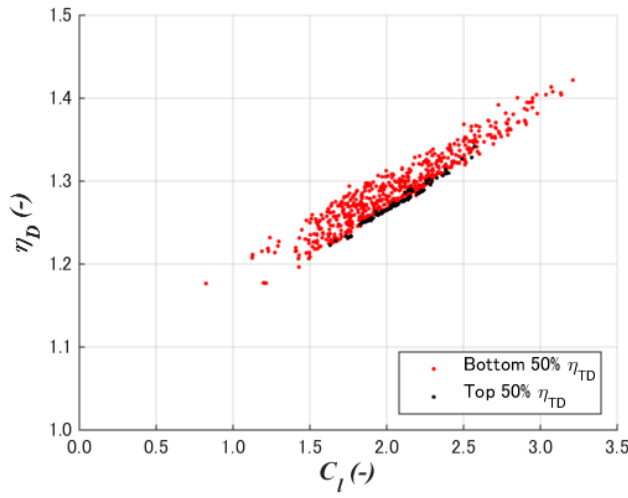
Figure 8. Diffuser efficiency to lift coefficient.